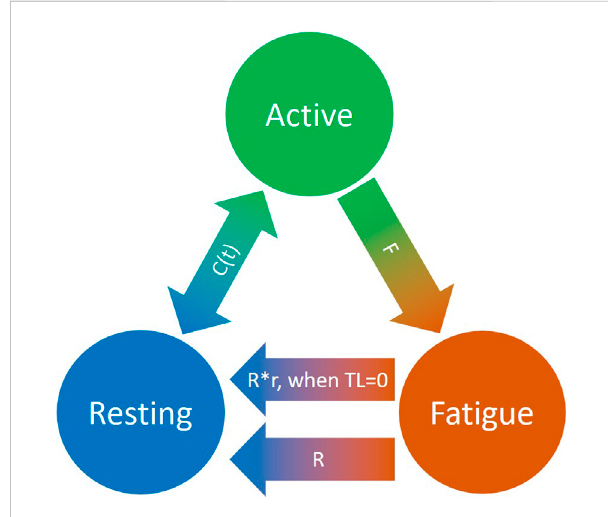
FIGURE 4 Schematic representation of the revised three-compartment controller(3CCr)mathematicalfatiguemodelreproducedfrom(Frey- Law et al., 2021) licensed under CC BY-NC-ND 4.0, where C (t) is the feedback controller used to match Ma to target load, TL; F de fi nes fatigue rate and R de fi nes recovery rate, with additional recovery during rest periods signi fi ed by